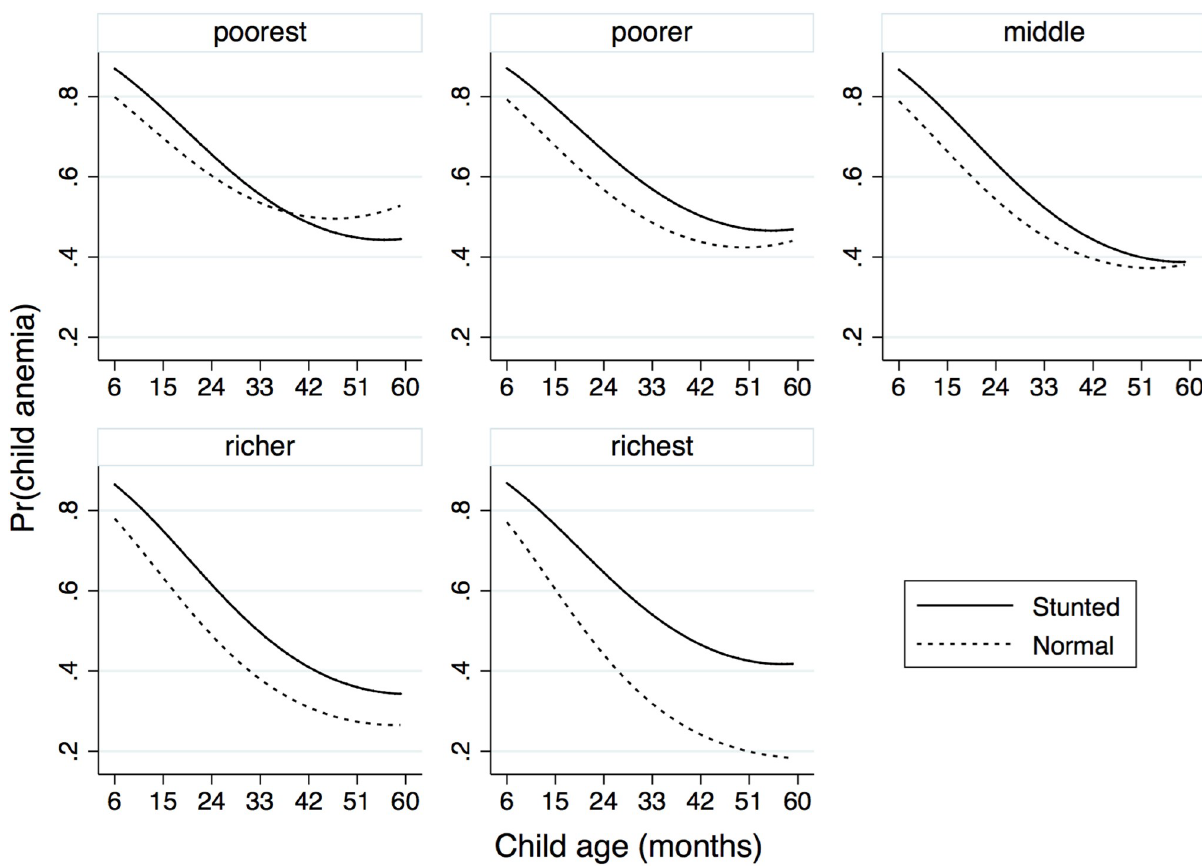
Fig 1. Interaction plot describing the effect of interaction between stunting, SES and age on the risk of child